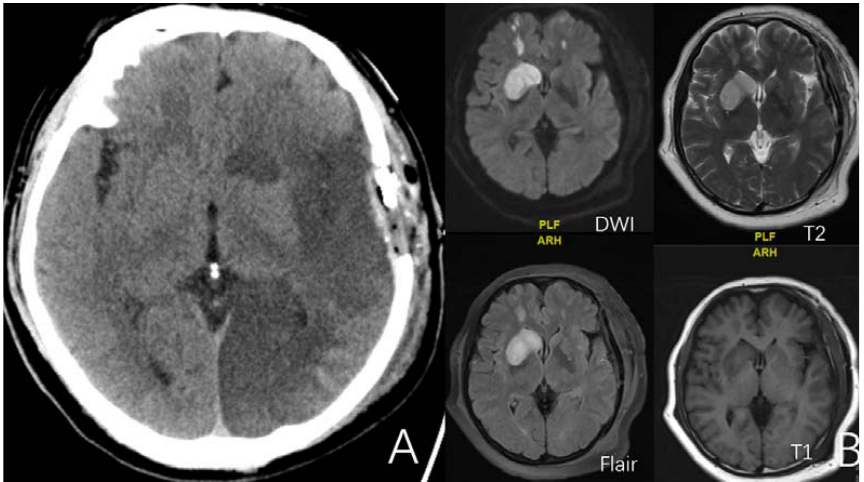
Figure 2. ( A ) is a 52 ‐ year ‐ old female. CT showed massive infarct in the left cerebral hemisphere after surgery. ( B ) is a 52 ‐ year ‐ old female. Four sequences of MRI exhibit the imaging features of minor cerebral infarction after surgery.